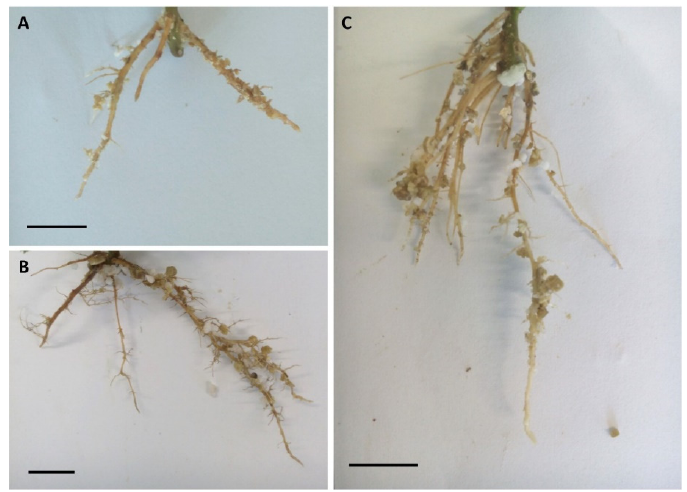
Figure 4. SM904 roots 3 weeks after induction with 1 g/L indole-3-butyric acid (IBA) and development ( A ) in distilled water and ( B , C ) adapted MMN. Shoots were previously elongated in ( A , B ) MSB and ( C ) WPMZ. Bar = 1 cm.